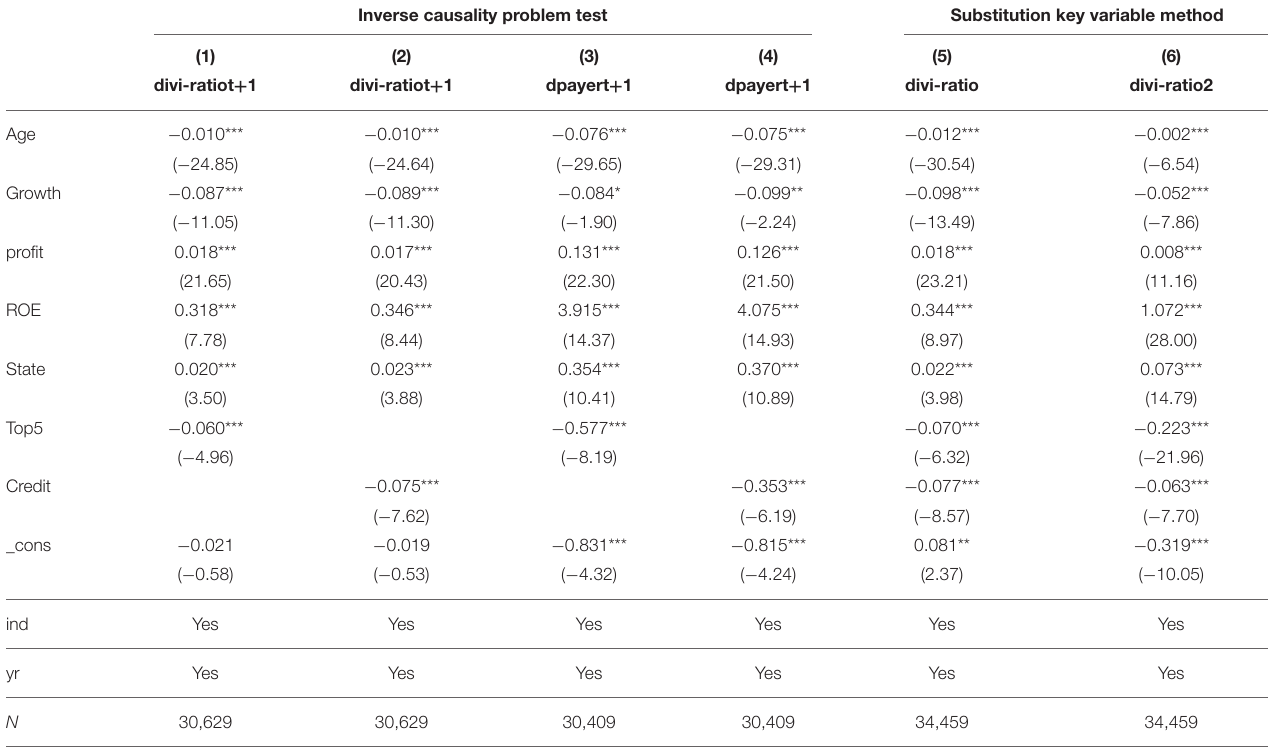
TABLE 3 | Inverse causality problem test and the substitution key variable